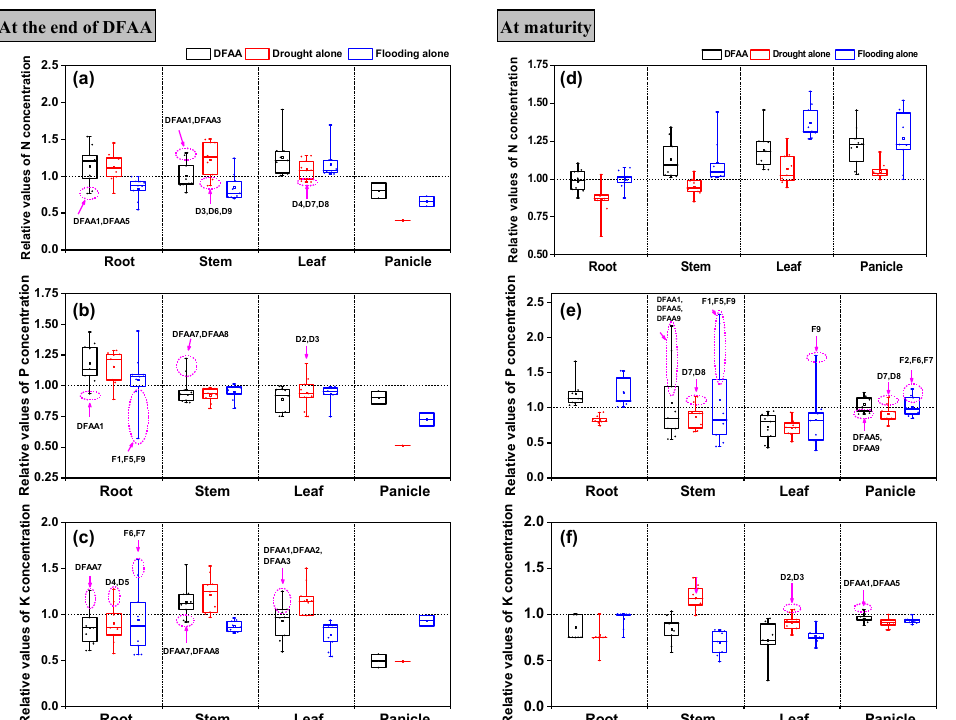
Figure 4. The relative value changes of rice tissue concentrations of nitrogen (N), phosphorus (P) and potassium (K) under different water stresses ( a – c ) at the end of drought–flood abrupt alternation (DFAA) and ( d – f ) at maturity. The relative values plotted on the y-axis were calculated by the ratios of water stress groups to the normal group. The boxes represent the range of relative values in rice root traits. Round dots ( ● ) in the boxes represent the means for each group. The ellipses plotted over the bars refer to some outstanding treatments, marked with the arrows and text next to the side.